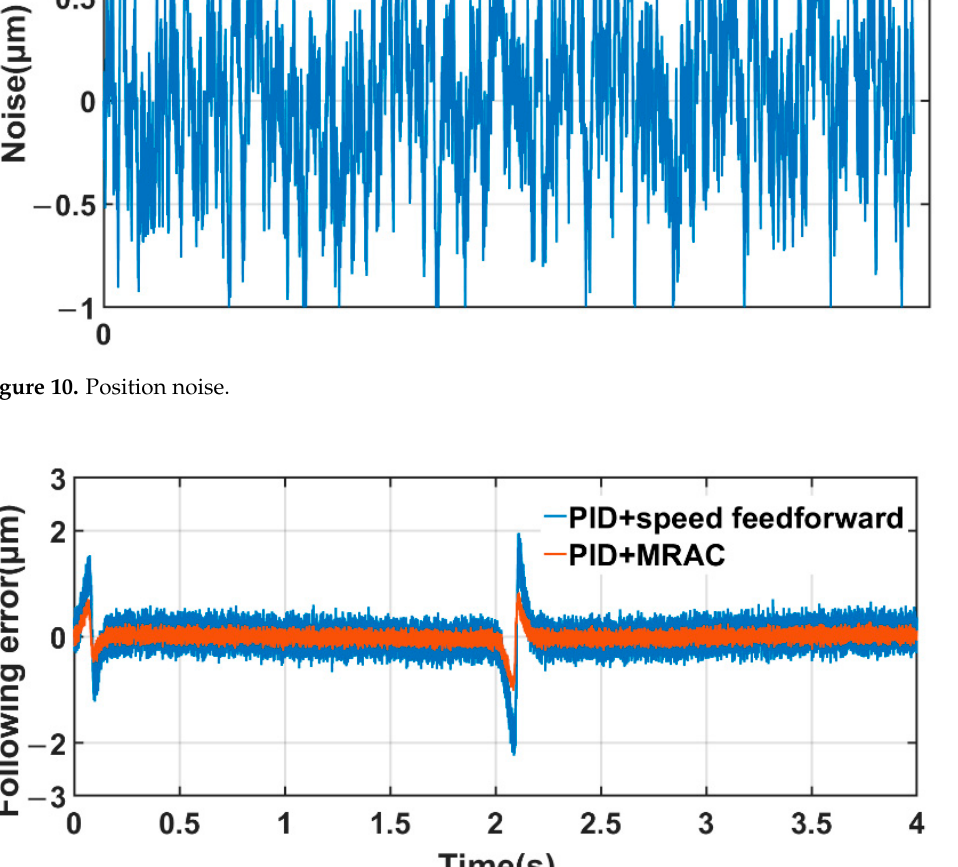
Figure 11. Comparison of the following error of two methods.